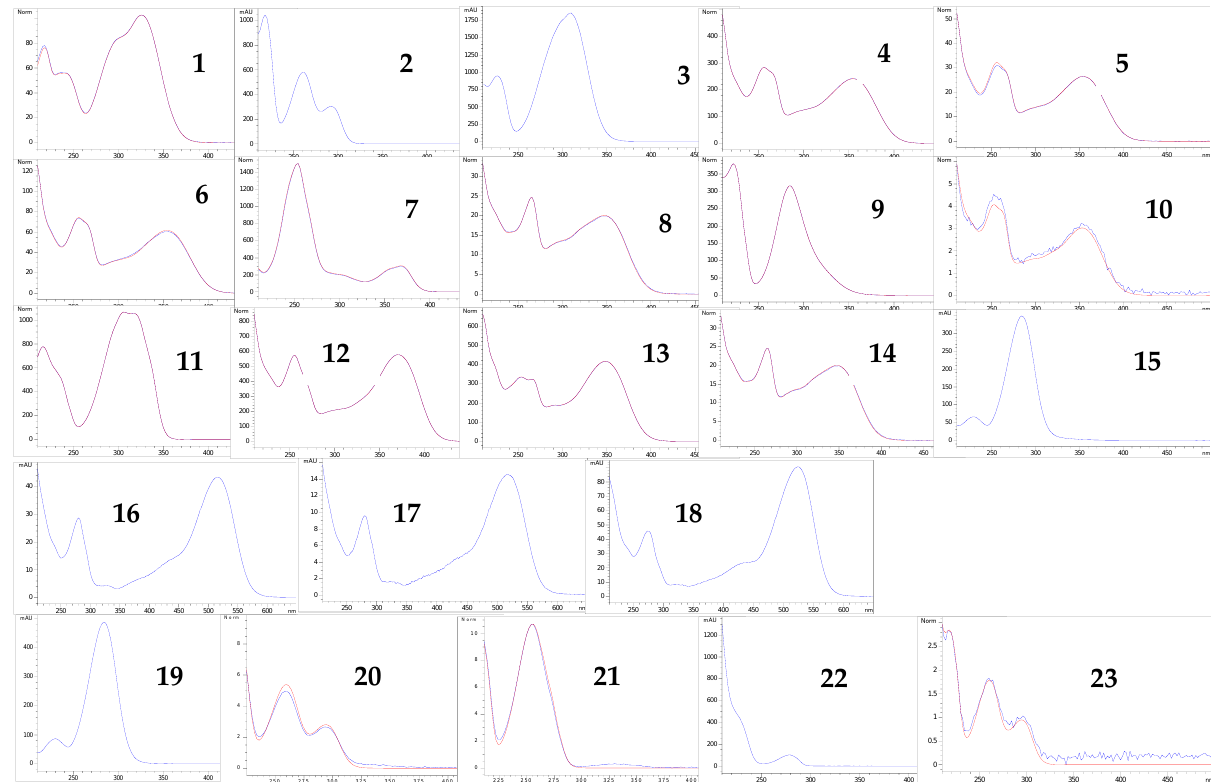
Figure 6. UV spectra of identified compounds present in the investigated samples (the numbers refer to corresponding peaks, presented in Table 2).